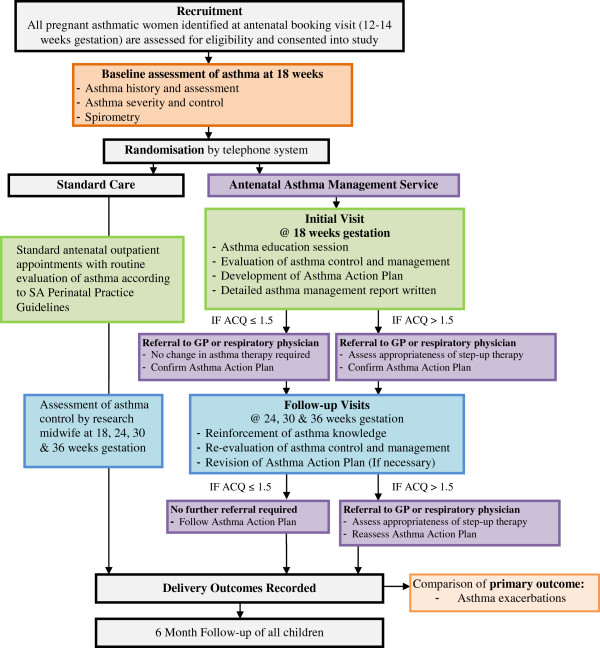
AAMS study design.